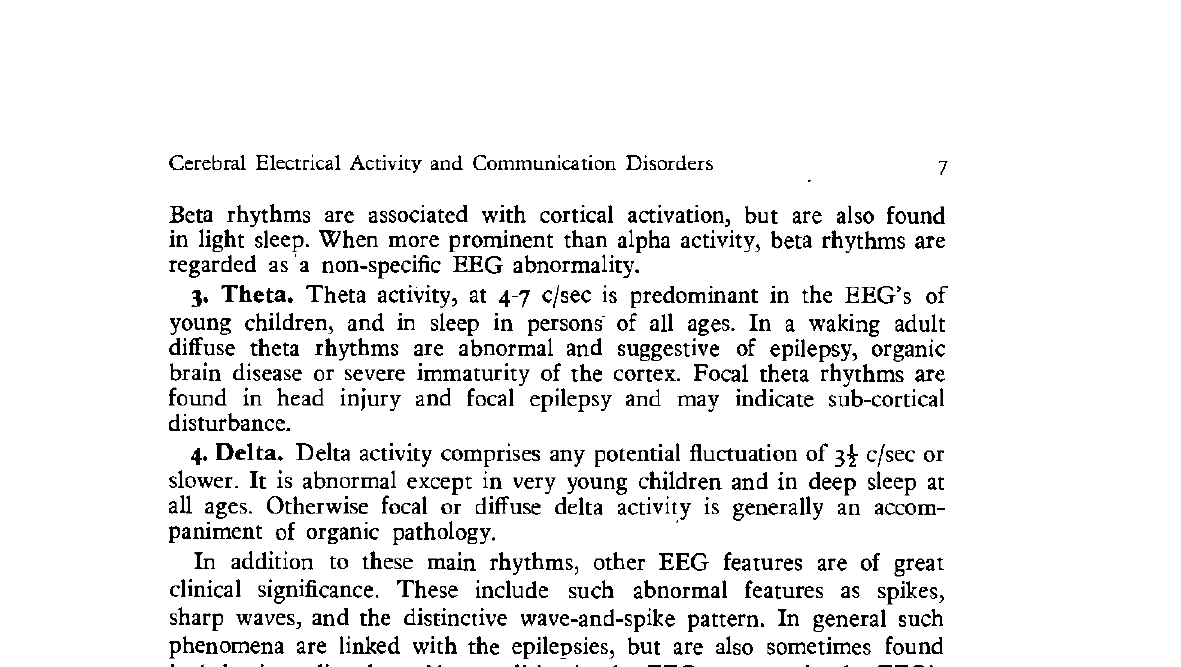
TABLE I: E EG ABNORMALITIES AND THEIR MAIN CLINICAL